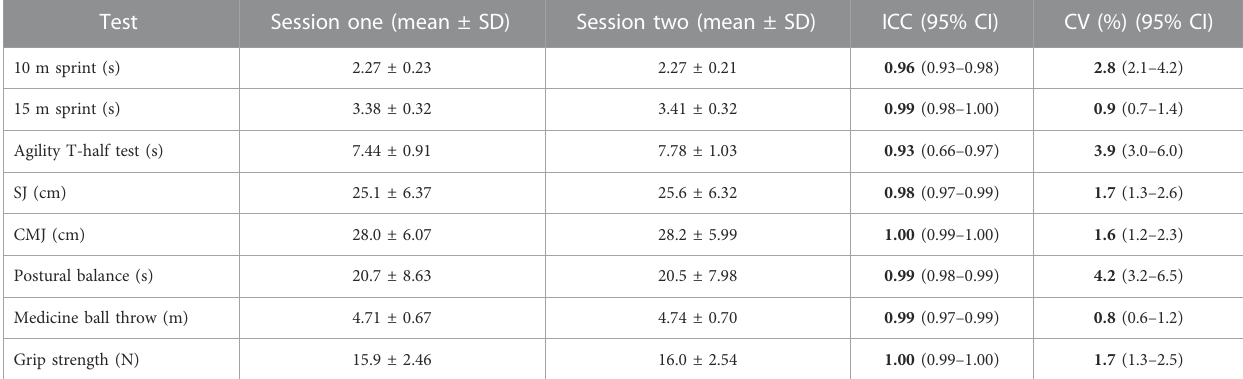
TABLE 1 Fitness test data from two sessions ( n = 45). Descriptive statistics and intrarater reliability are presented for each test. Intraclass correlation coef fi cient (ICC) ≥ 0.75 and coef fi cient of variation (CV) ≤ 10% marked in bold. Data are reported as mean ± standard deviation